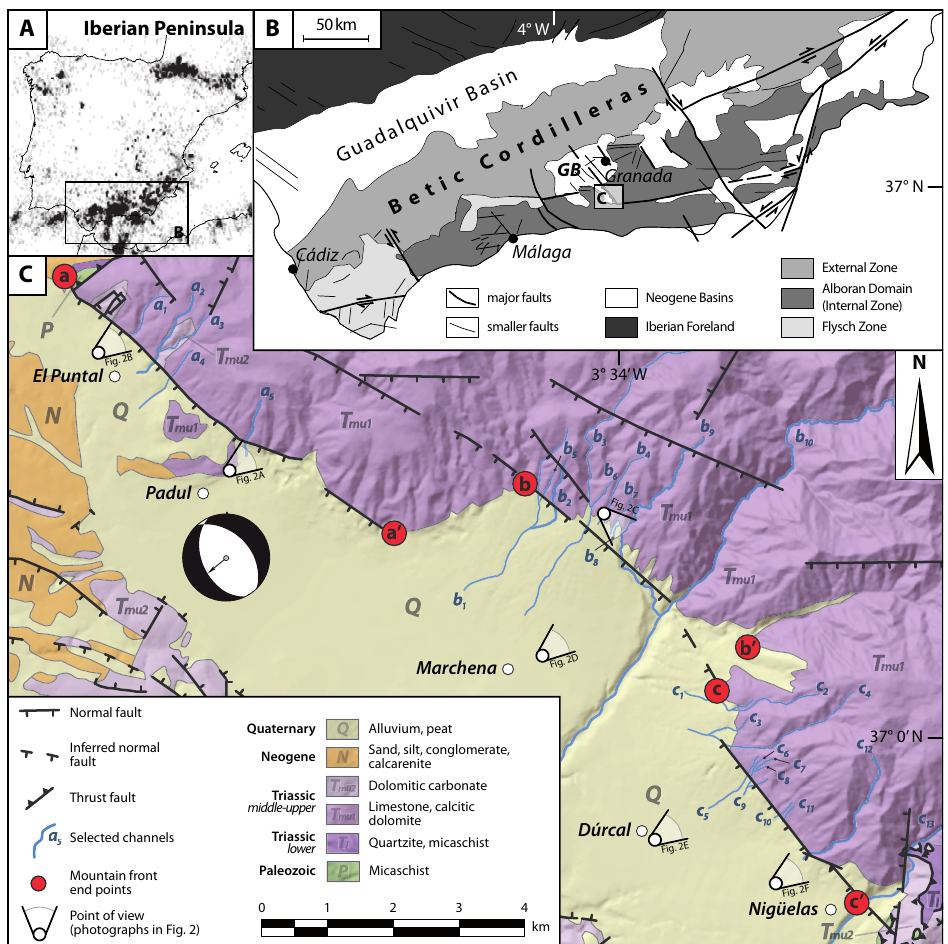
Figure 1. [A] Earthquake point density map of the Iberian Peninsula, based on USGS earthquake data (1973-2013, M>0) [B] Generalized ge- ological map of southern Spain with the main geological units, and major fault systems. The extent of the map is marked in [A]. GB: Granada Basin (after Reicherter and Peters [2005]). [C] Simplified geological map of the Padul-Nigüelas Fault Zone (PNFZ) including the position of hardrock faults, other faults and the major lithological units in the surrounding area of the PNFZ, compiled from own data and published geological maps [Sanz de Galdeano et al. 1975, González Donoso et al. 1978]. The end points of the lines for the calculation of the moun- ) are plotted as red dots and mark the Padul (a-a’), Marchena (b-b’) and Dúrcal (c-c’) segments. Used channels ( a tain front sinuosity ( S mf b , c ) for the morphotectonic analysis (see Figures 3-5) are plotted as blue lines. The fault plane solution is taken from Muñoz et al. [2002] 1-10 1-13 and based on microtectonic measurements. The extent of the map is marked in [B]. Additionally, the viewing locations for the field photo- graphs presented in Figure 2 are